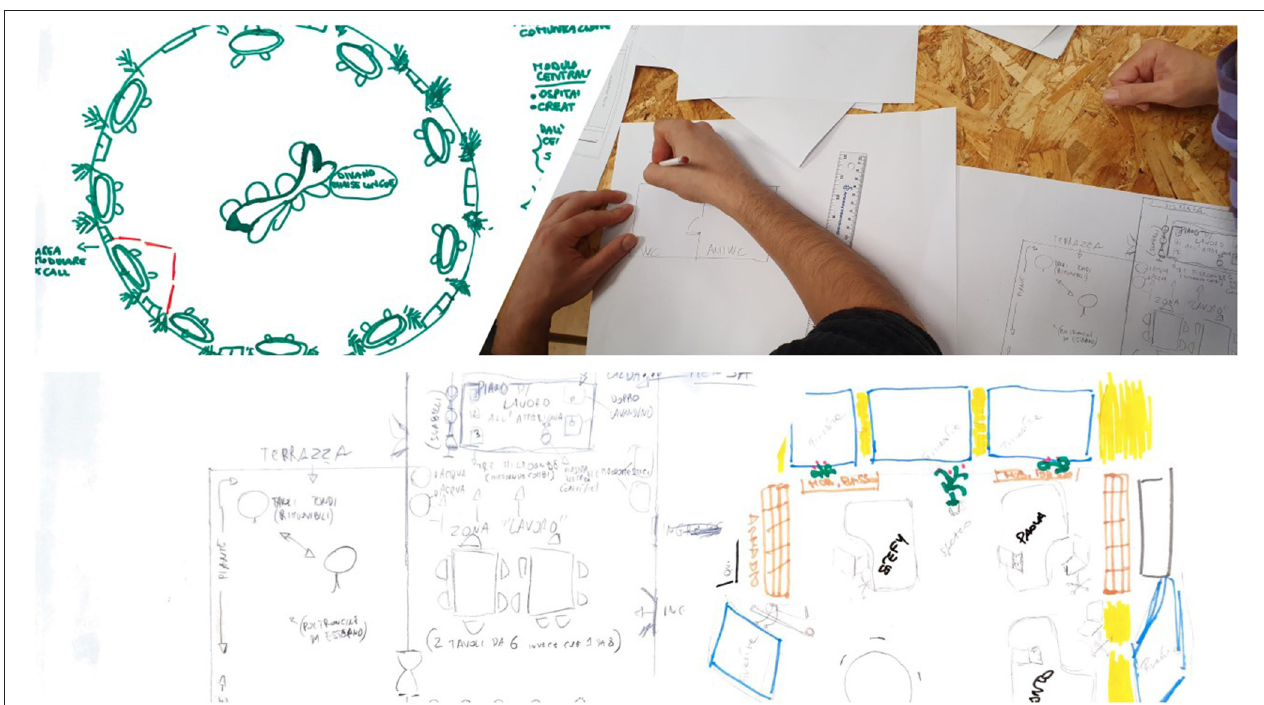
FIGURE 2 | Examples of participants’ drawings of the formal and informal common spaces of the new headquarters (Step 1 - Session